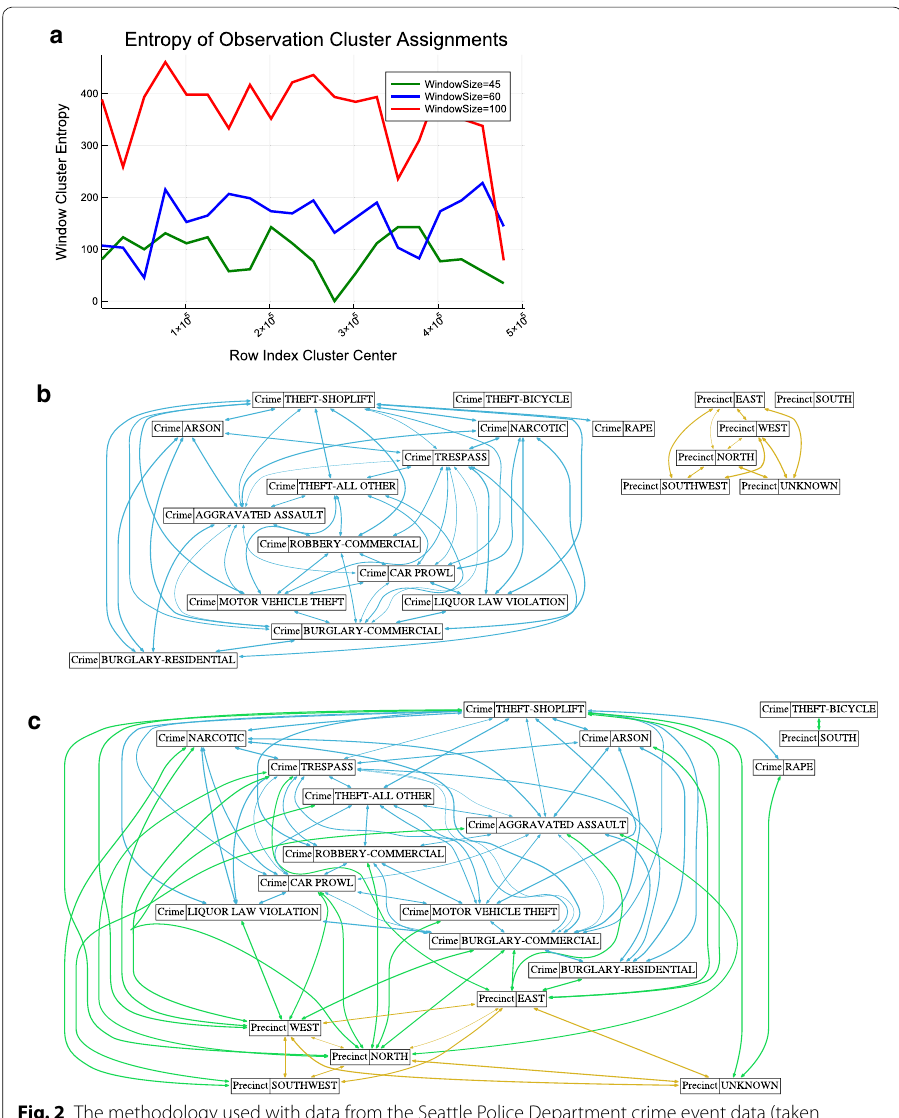
Fig. 2 The methodology used with data from the Seattle Police Department crime event data (taken from data.gov) where the type of ‘Crime’ and the ‘Precinct’ are used. a Shows the cluster entropy trace for the window size set. b Shows the walks of length 2 between labels (triangulation) of the variable which is effectively the sharing of label values in events. For this example this corresponds to crime types having been reported in the same precinct (left/blue edges) and for different precincts to have an edge they have at least 1 common crime reported. c Has 3 different edge types for the walks of length 2 between variable labels and the length 1 of the number of label co-occurrence counts between different